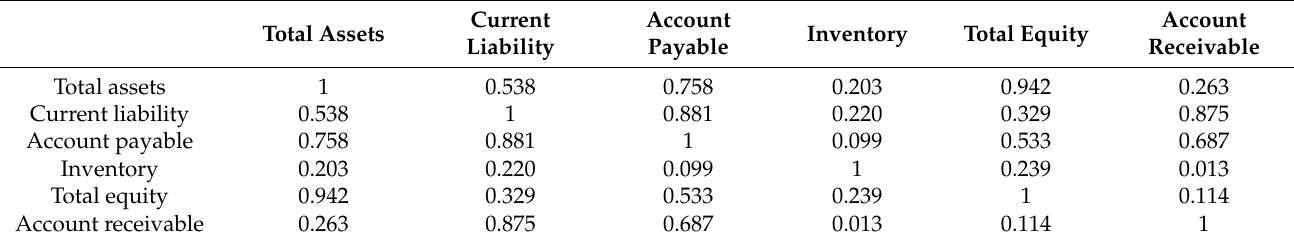
Table 9. Correlation of input and output data in